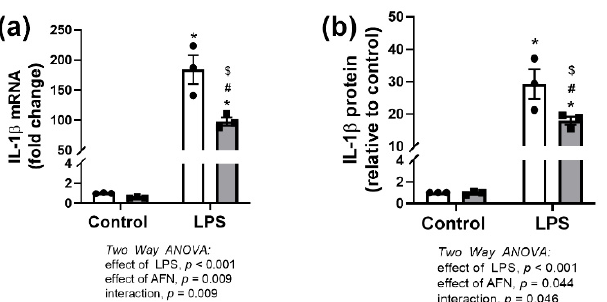
Figure 2. IL-1 β is suppressed by AFN. ( a ) IL-1 β mRNA (collected at 2 h) and ( b ) protein (collected at 6 h) was measured in LPS and AFN-treated MH-S cells. White bars indicate DMSO control, and grey bars indicate AFN-treated. Data were analyzed by two-way ANOVA to identify the effects of LPS and/or AFN exposure. Tukey’s post-hoc analysis was used to determine significant differences between groups; n = 3 individual experiments. * p < 0.005 from control non-stimulated; # p < 0.005 from AFN non-stimulated; $ p < 0.05 from control LPS.